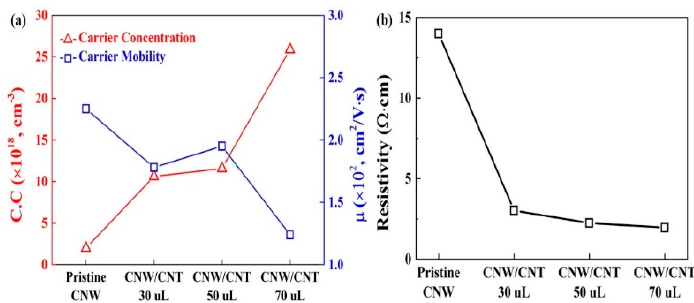
Figure 4. Electrical properties of all samples: ( a ) carrier concentration and carrier mobility; ( b ) resistivity of all samples.